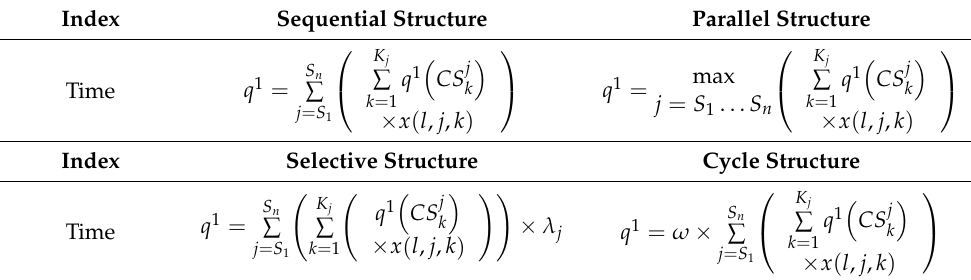
Table 7. QoS expressions of internal composite (Time).